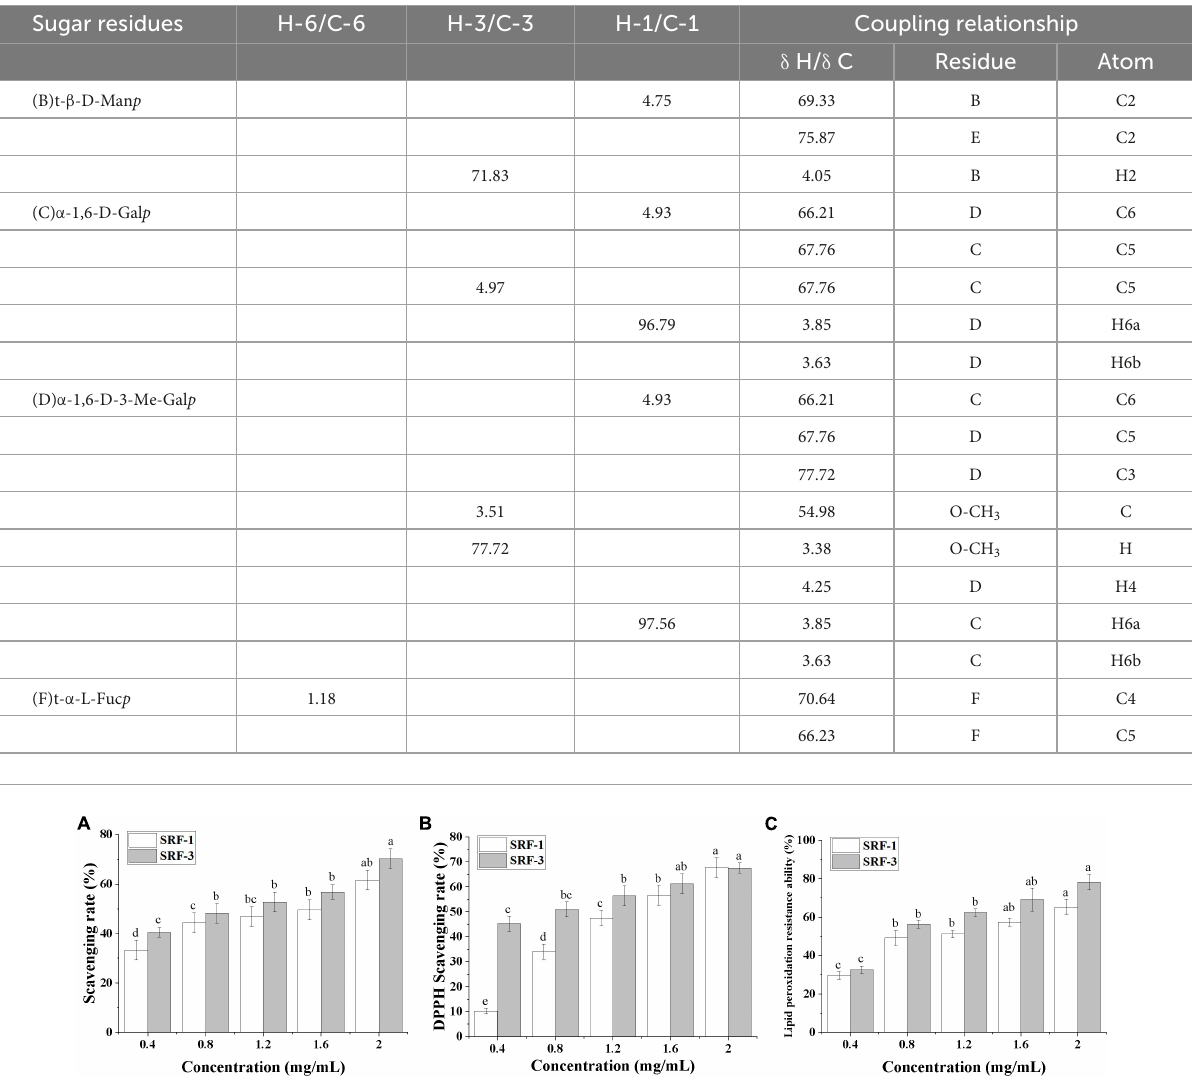
TABLE 4 HMBC spectrum chemical shifts of SRF-3.